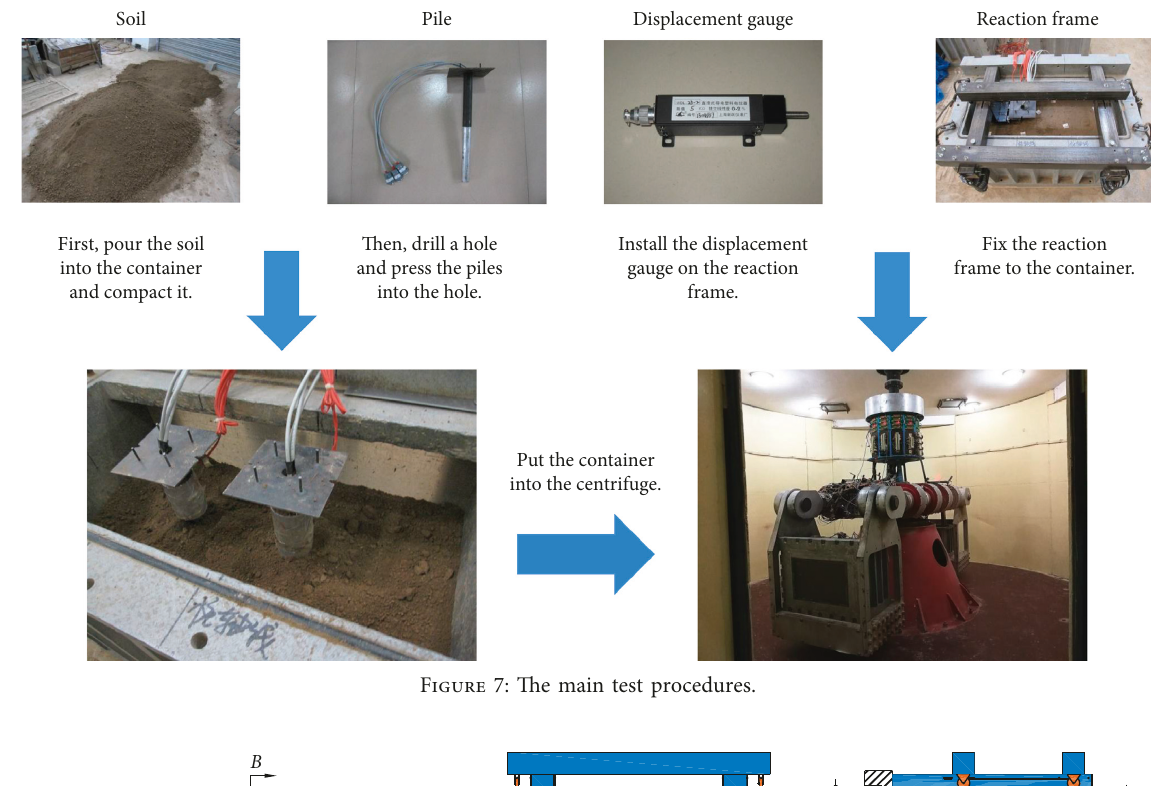
Figure 7: The main test procedures.